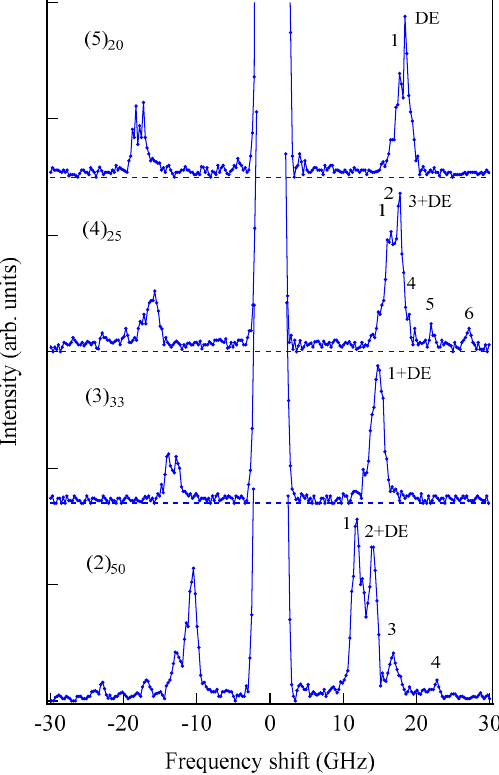
Figure 27. A comparison of BLS spectra observed from the integer-type FLSLs. The experimental conditions were the same as the ones given in Figure 25. The labels 1 to 5 and DE stand for the SSW modes and the DE mode, respectively [95].